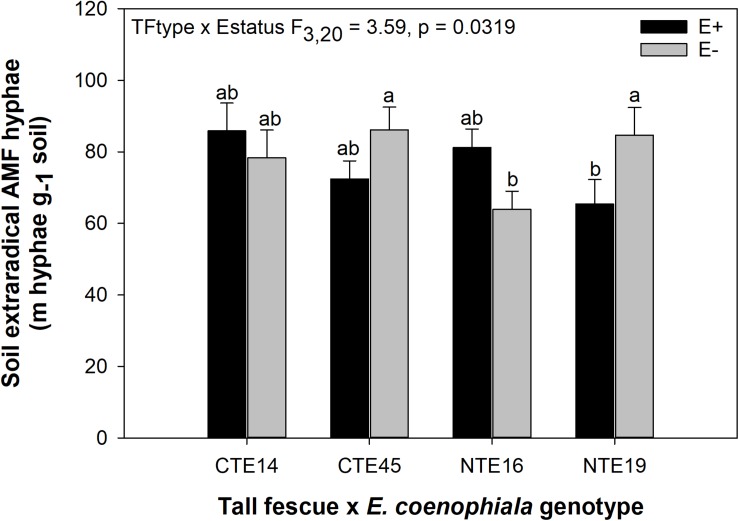
Interactive effects of tall fescue symbiotic genotype and endophyte status on the length of extraradical AMF hyphae (ERH) in root-associated soil. Bars indicate means ± 1 S.E. Bars sharing no common letter (a,b) indicate significant differences between means (α = 0.05).